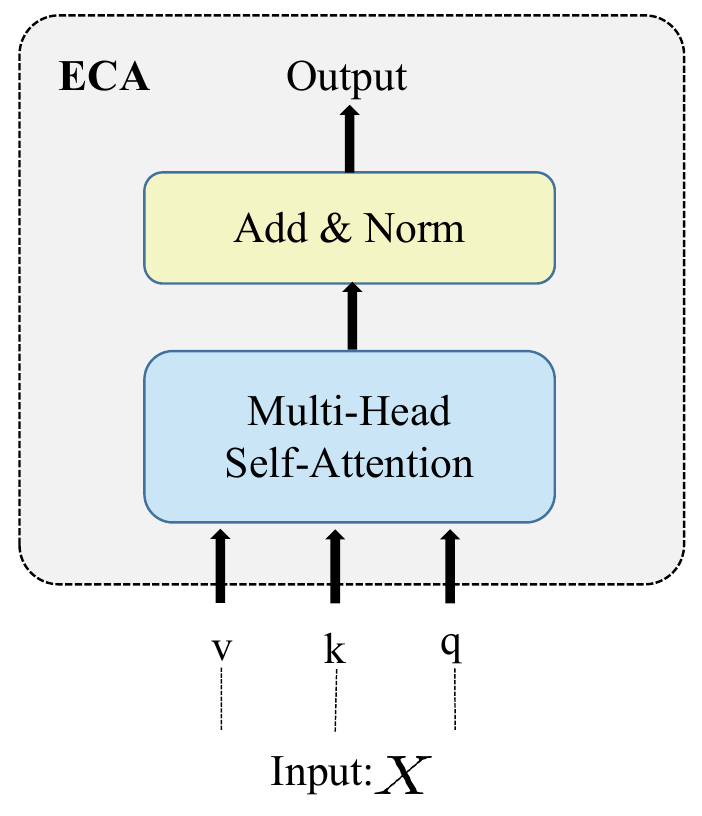
Figure 5. The structure of the ECA